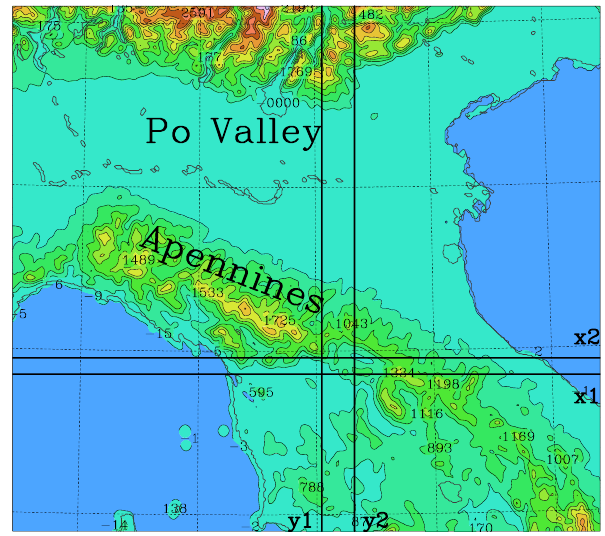
Fig. 1. Satellite image at 10:30UT 30 October 2008 showing wave trains in the lee of the Northern Apennines mountains and sev- eral rainbands at various stages of development. Image Copyright ©2008 EUMETSAT, courtesy V. Levizzani, ISAC-CNR.